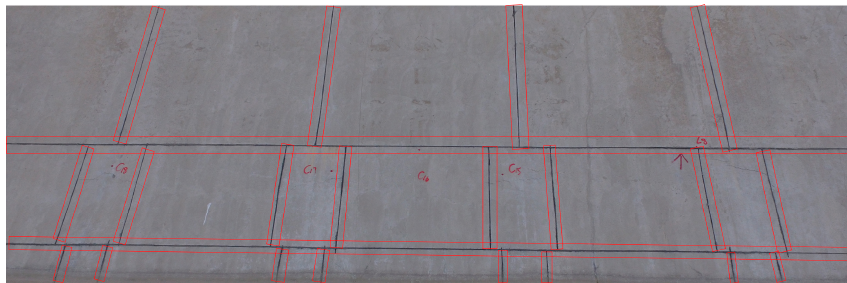
Figure 9. Regular expansion joints on the surface of concrete slope protection.